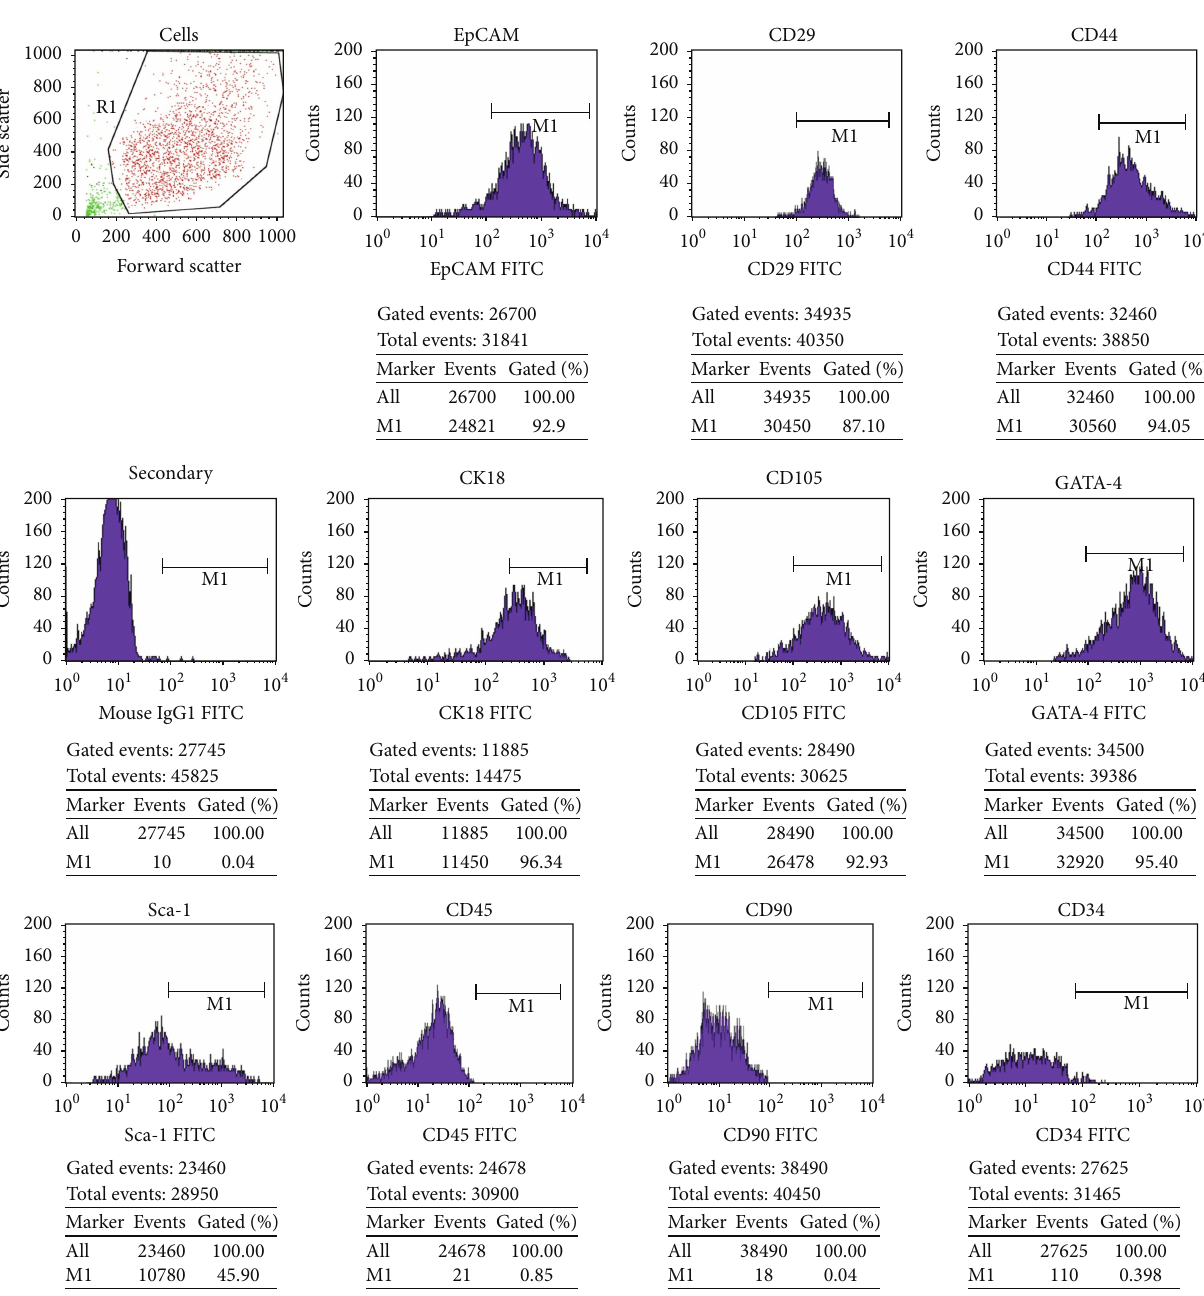
CD105, and CD29 ( 𝛽 1 integrin) more than 90% are